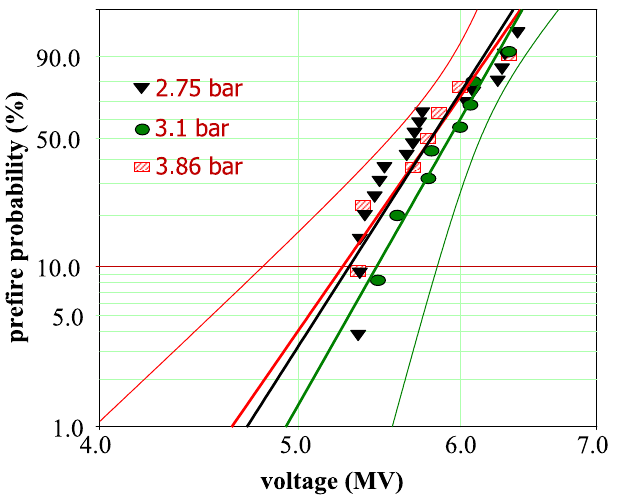
FIG. 10. (Color) Weibull analysis of self-closure data for hemi- spherical electrodes utilizing HD-17 trigger.